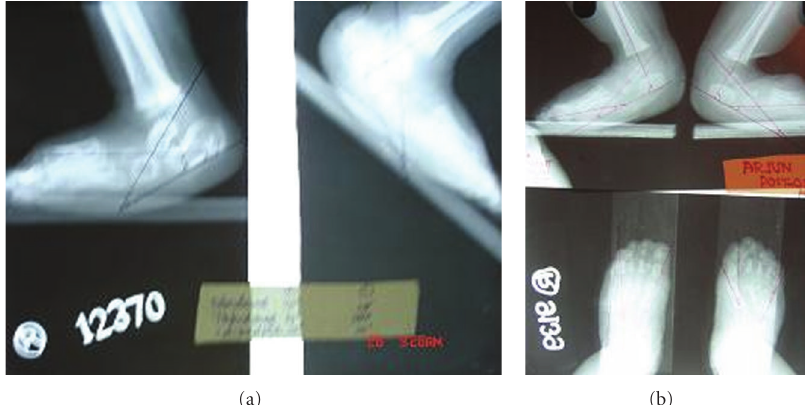
Figure 2: (a) X-rays AP and Lateral (stress dorsiflexion) of feet showing extend of various abnormal radiographic angles preoperatively. (b) X-rays AP and Lateral (stress dorsiflexion) of feet showing extend of various abnormal radiographic angles postoperatively.